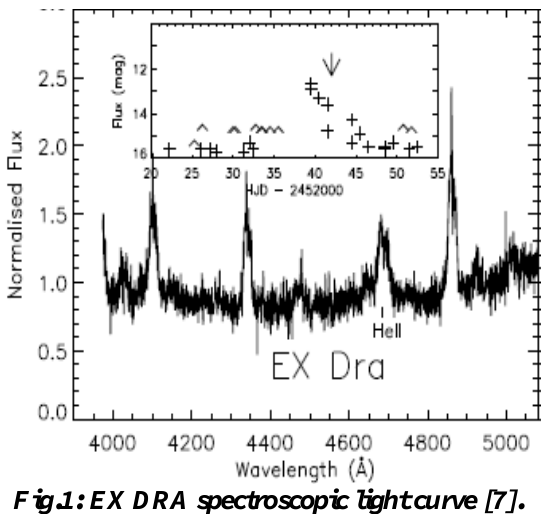
Fig.1: EX DRA spectroscopic light curve [7].